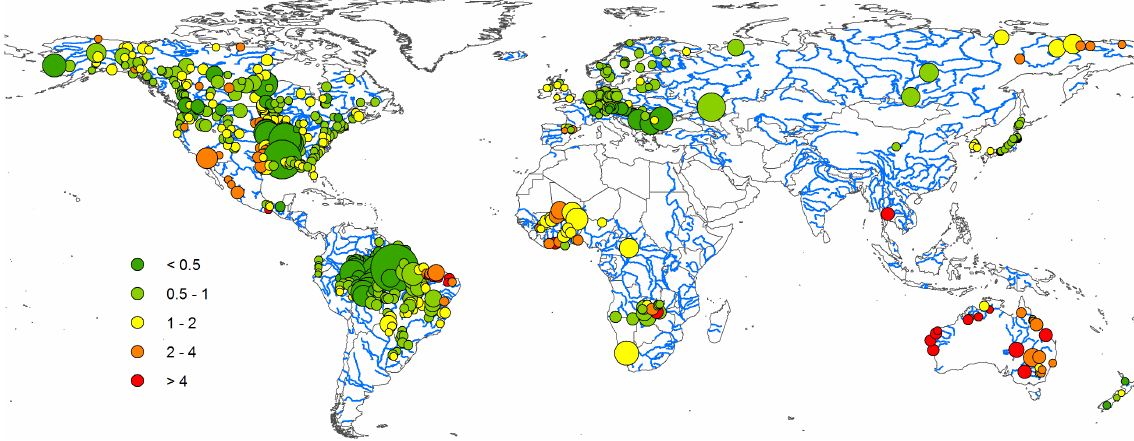
Fig. 2. Coefficient of variation of the estimation residuals for the 620 stations considered. Circle size is proportional to the upstream area of the river station.